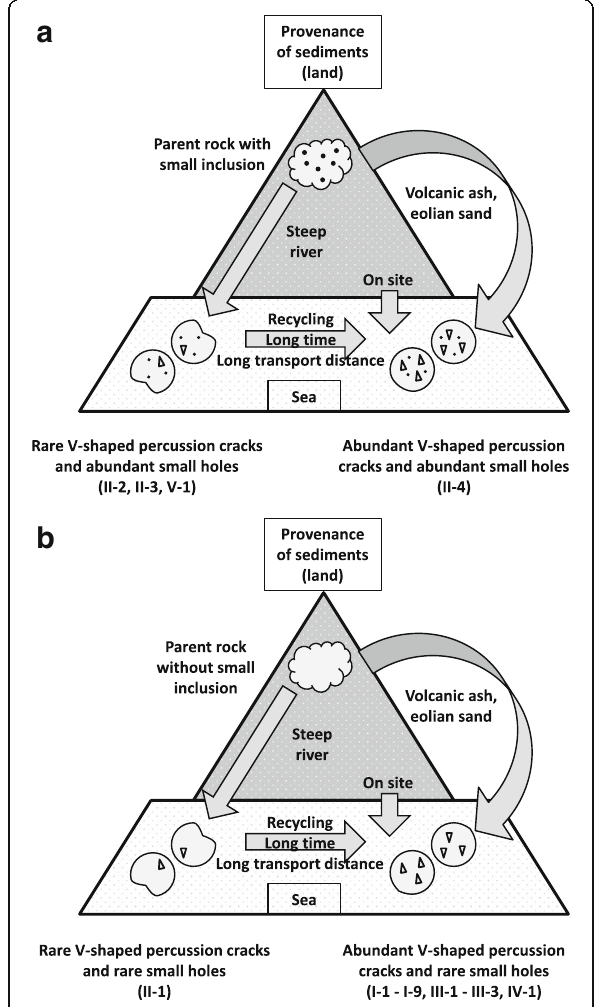
Fig. 5 Model depicting the quartz grain history from production to deposition and the diversity of grain surface microtexture: a grains with abundant small inclusions and b grains with few small